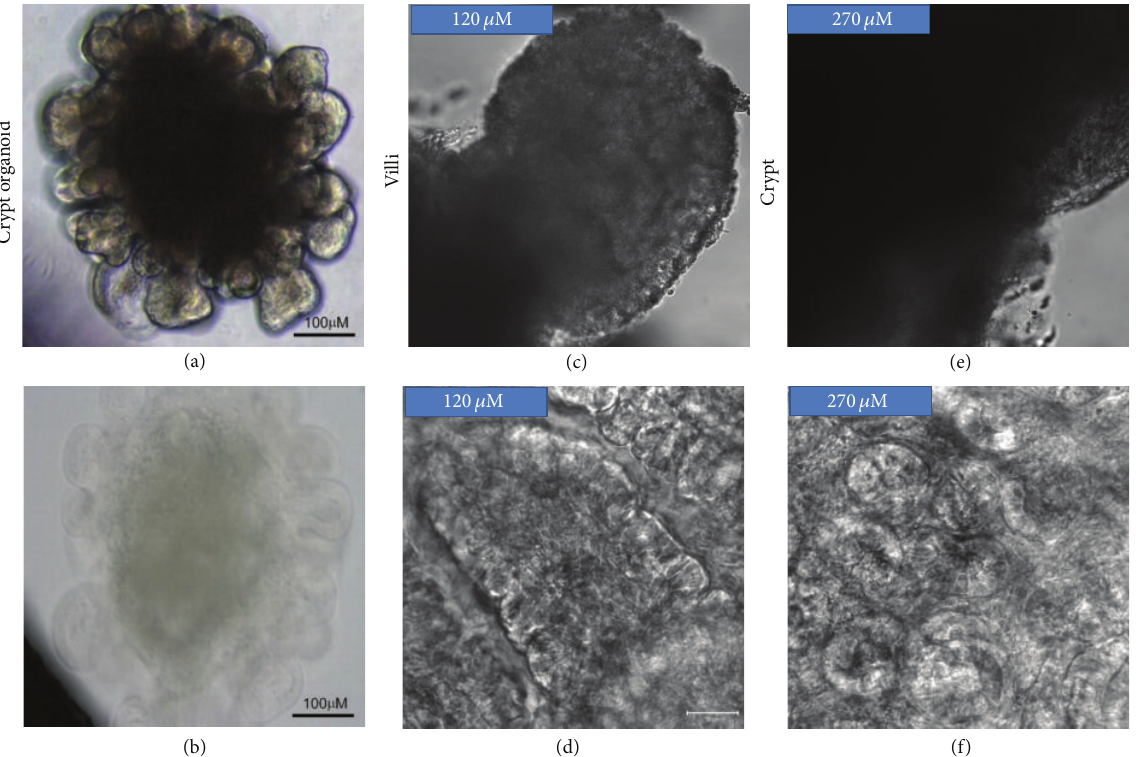
Figure 1: Optical clearing increased light transmission of the crypt organoids and small bowel mucosa. (a) Crypt organoid in PBS. (b) Optically cleared crypt organoid. (c) Small bowel mucosa in PBS at 120 𝜇 m deep below the villus top. (d) Optically cleared small bowel mucosa at 120 𝜇 m deep below the villus top. (e) Small bowel mucosa in PBS at 270 𝜇 m deep below the villus top. (f) Optically cleared small bowel mucosa at 270 𝜇 m deep below the villus top. Bar: 100 𝜇 m.